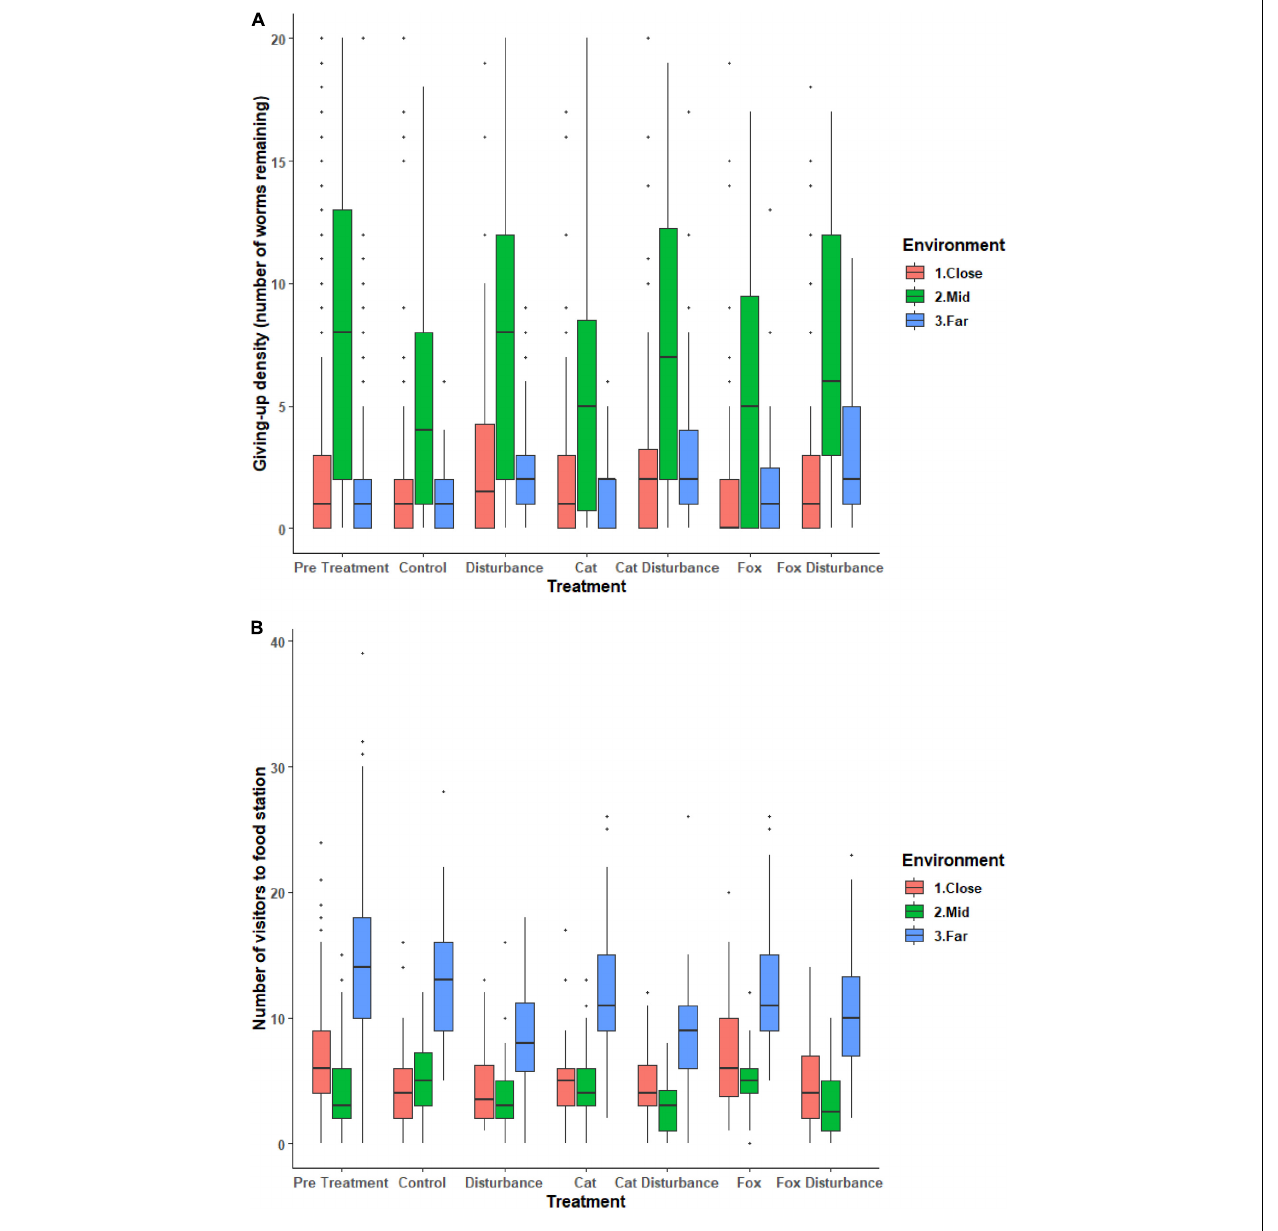
FIGURE 1 | Boxplots of raw data for the (A) GUD (giving-up density: number of mealworms remaining after 12 h overnight exposure), and (B) number of fauna visitors to a giving-up density station for each environment and treatment. Vertical lines represent the standard error. Horizontal lines represent the mean. Dots represent measurements that were not consistently recorded but were retained in the